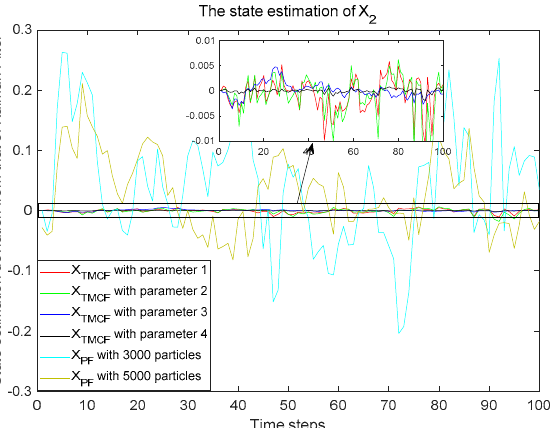
Figure 10. Difference between the state estimation results of different algorithms and those of KF for x 2 .